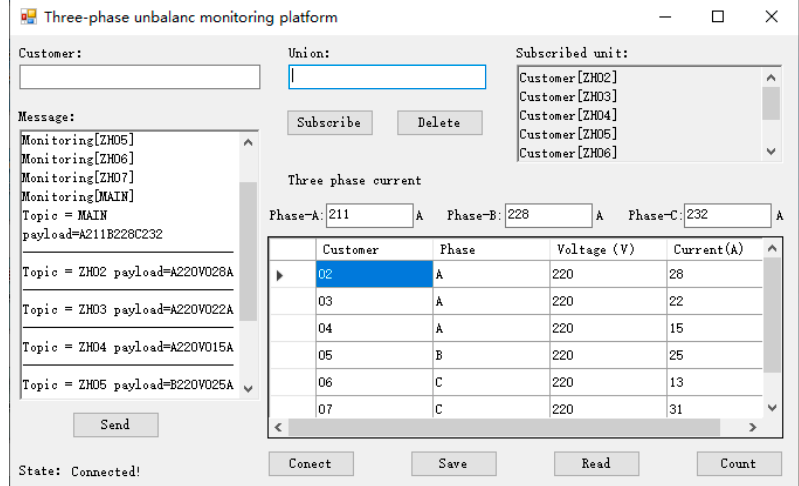
Figure 12. Intelligent monitoring platform.